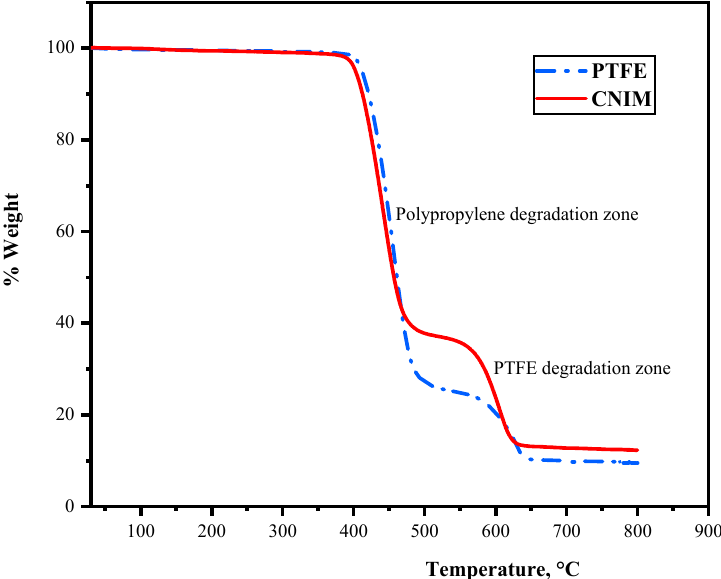
Figure 2. TGA curve for control PTFE and CNIM membrane.